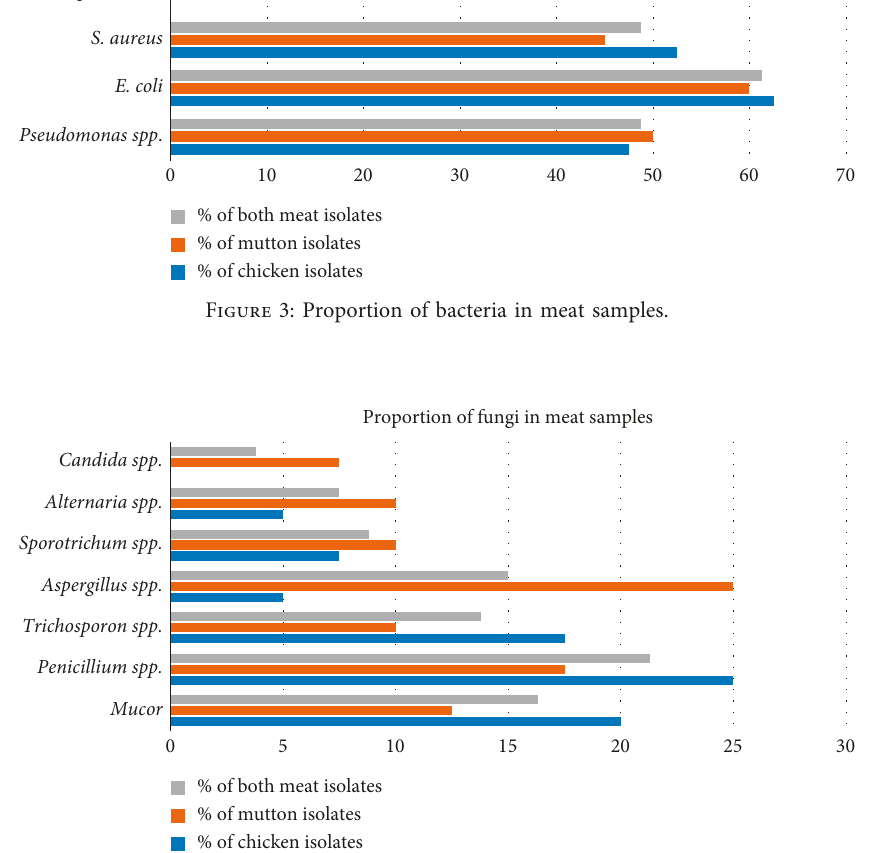
Figure 4: Proportion of fungi in meat